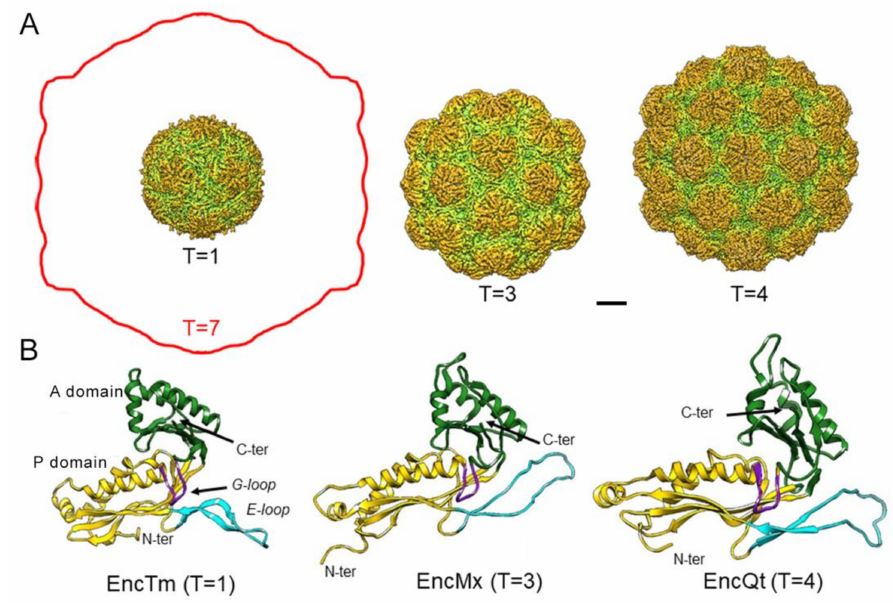
Figure 2. Structure of encapsulin nanocompartments. ( A ) Encapsulin nanocompartment size in- creases with the triangulation number (T), from (left to right) T. maritima (EncTm; PDB entry 3dkt) with a T = 1, M. xanthus (EncMx; EMD accession code 5917) with a T = 3 to Q. thermotolerans (EncQt; EMD accession code 9383) with a T = 4 shell. For comparison, the contour of the HK97 bacteriophage capsid with a T = 7 lattice is outlined (red). Bar, 50 Å. ( B ) Ribbon diagrams of EncTm (PDB entry 3dkt), EncMx (PDB entry 4pt2), and EncQt (PDB entry 6nj8). The N and C termini are indicated. The encapsulin fold has three major domains: A domain (green), P domain (yellow), and the E-loop (cyan). The G-loop is indicated